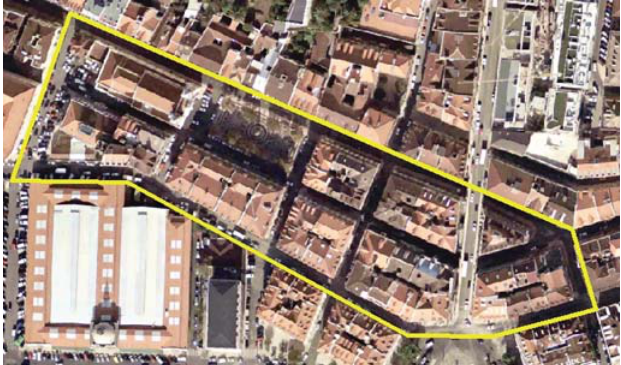
Figure 1. Study area marked by yellow line